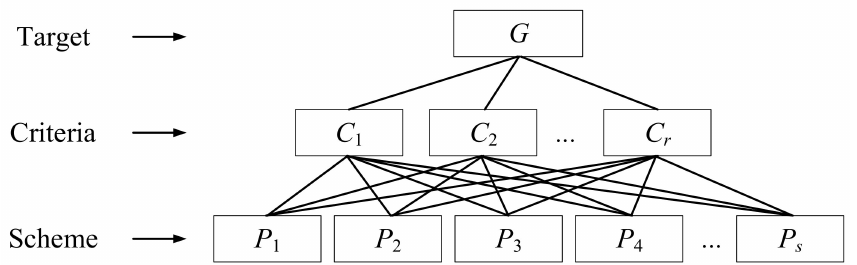
Figure 1. Existing